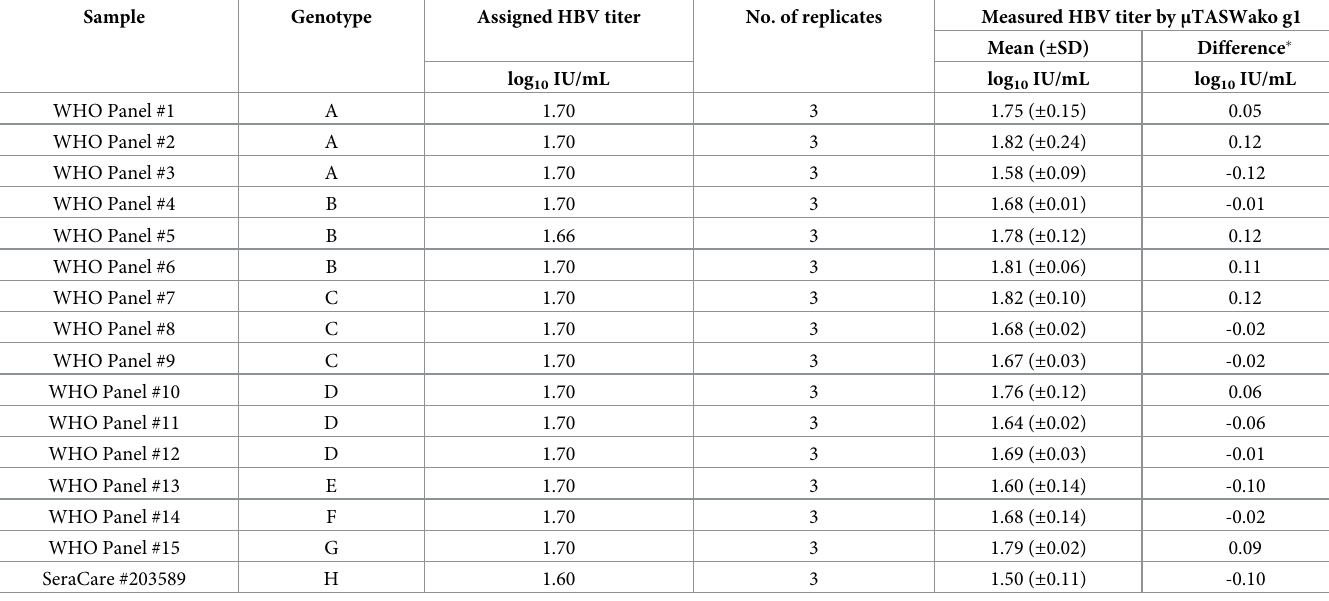
Table 3. Accuracy for HBV genotypes on μ TASWako g1 analyzer.